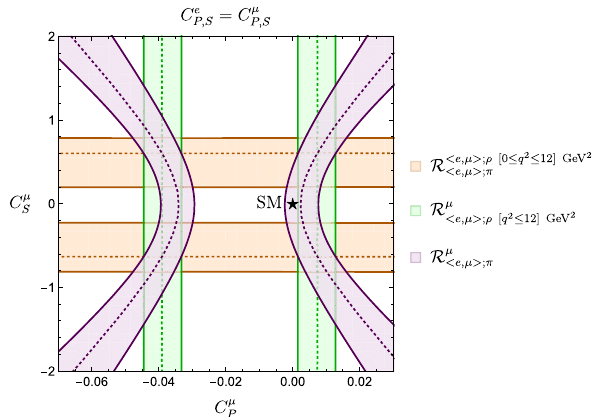
μ μ – C plane considering the observ- P S